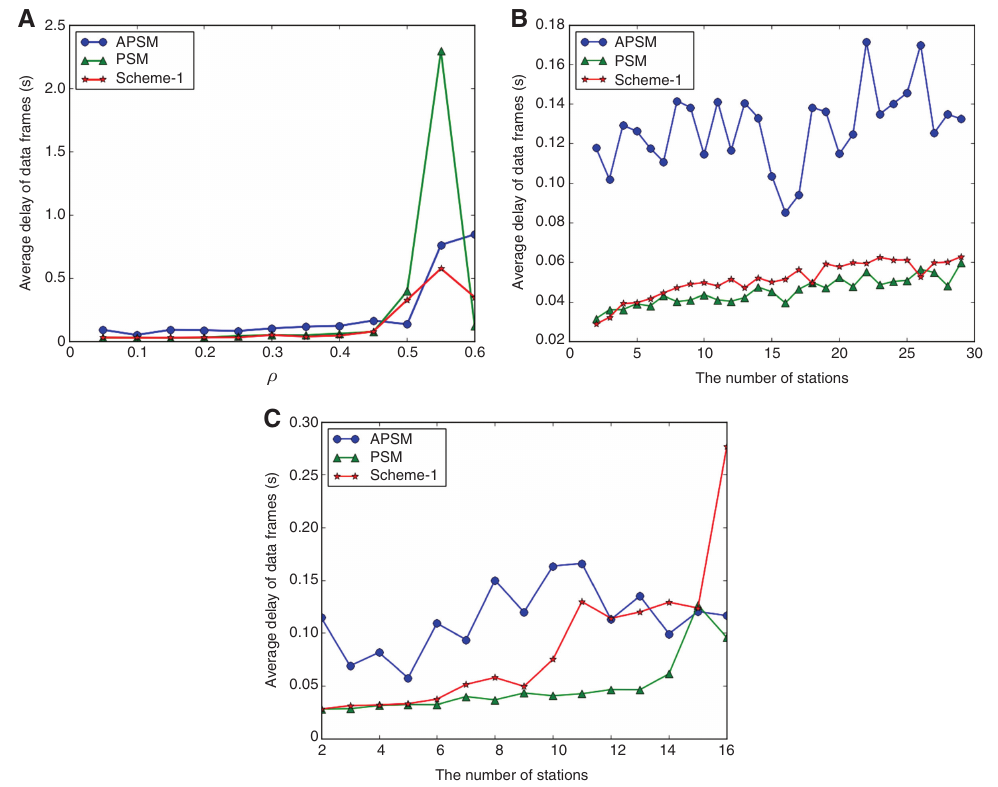
Figure 5. Comparison of Average Delay of Data Frames Under PAR Traffic.